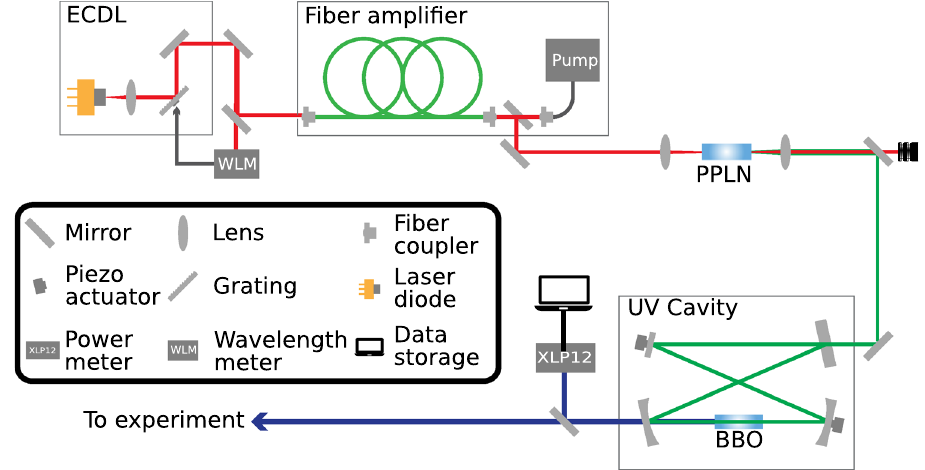
Figure 2. Schematic view of the continuous-wave laser